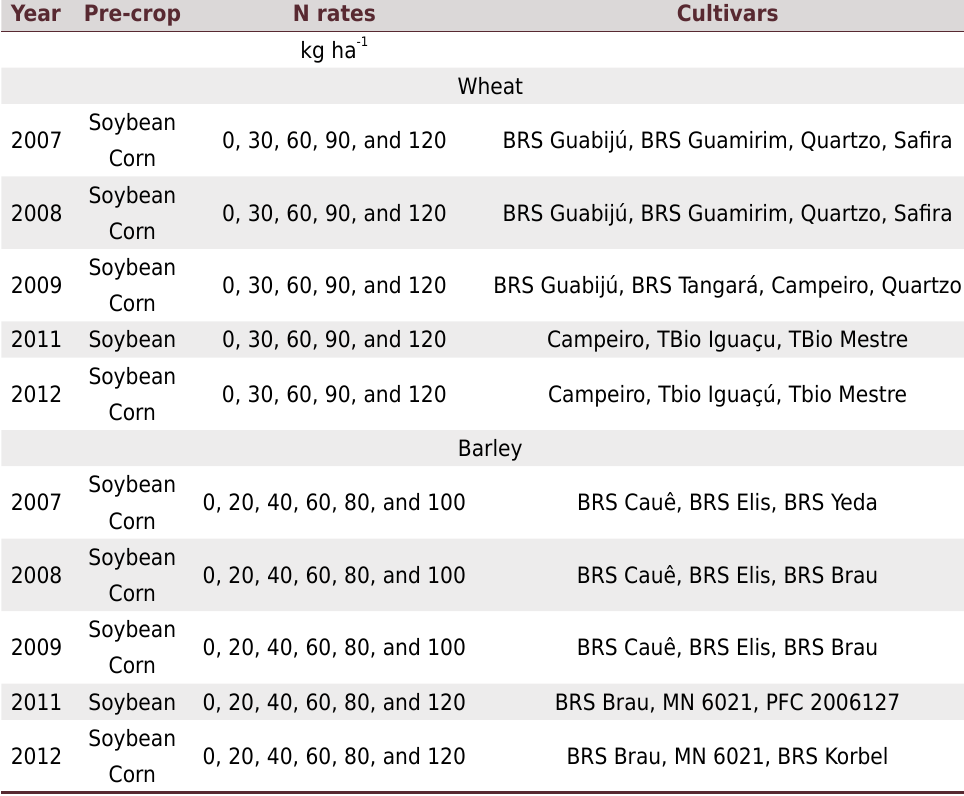
Table 1. Preceding crops, N rates, and cultivars used in the N fertilization experiments of wheat and barley conducted from 2007 to 2012 in the South-Central region of Paraná, Brazil Year Pre-crop N rates Cultivars kg ha -1 Wheat 2007